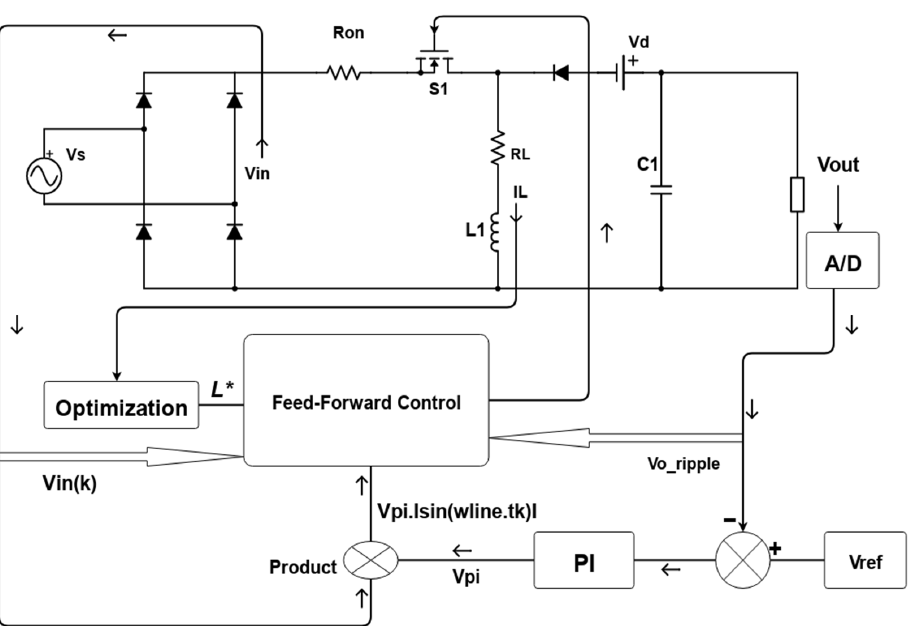
Figure 7. Control scheme with control loops in terms of optimization technique inclusion.